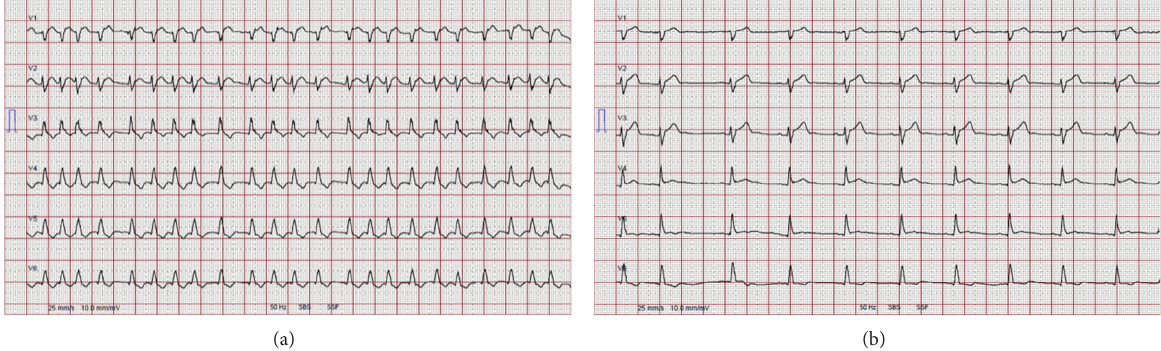
Figure 2: (a) The ECG of this 61-year-old patient 3 days after aortocoronary bypass grafting shows atrial fibrillation (HR 129–136/min) and a left bundle branch block. (b) After 2 doses of vernakalant, the patient converted into sinus rhythm (HR 57/min). Bradycardia decreased SvO 2 to 49% and required temporary atrial pacing via the existing epicardial